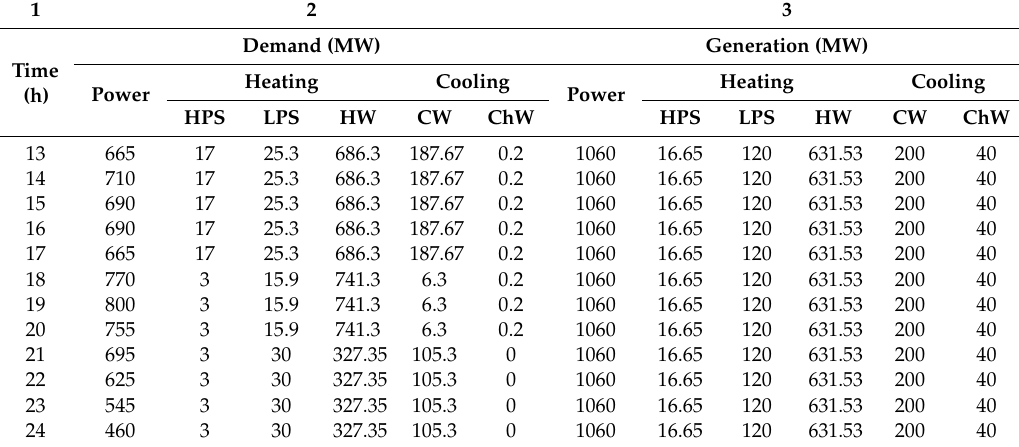
Table A2. TriGenSCA before iteration from time 13 to 24 h.